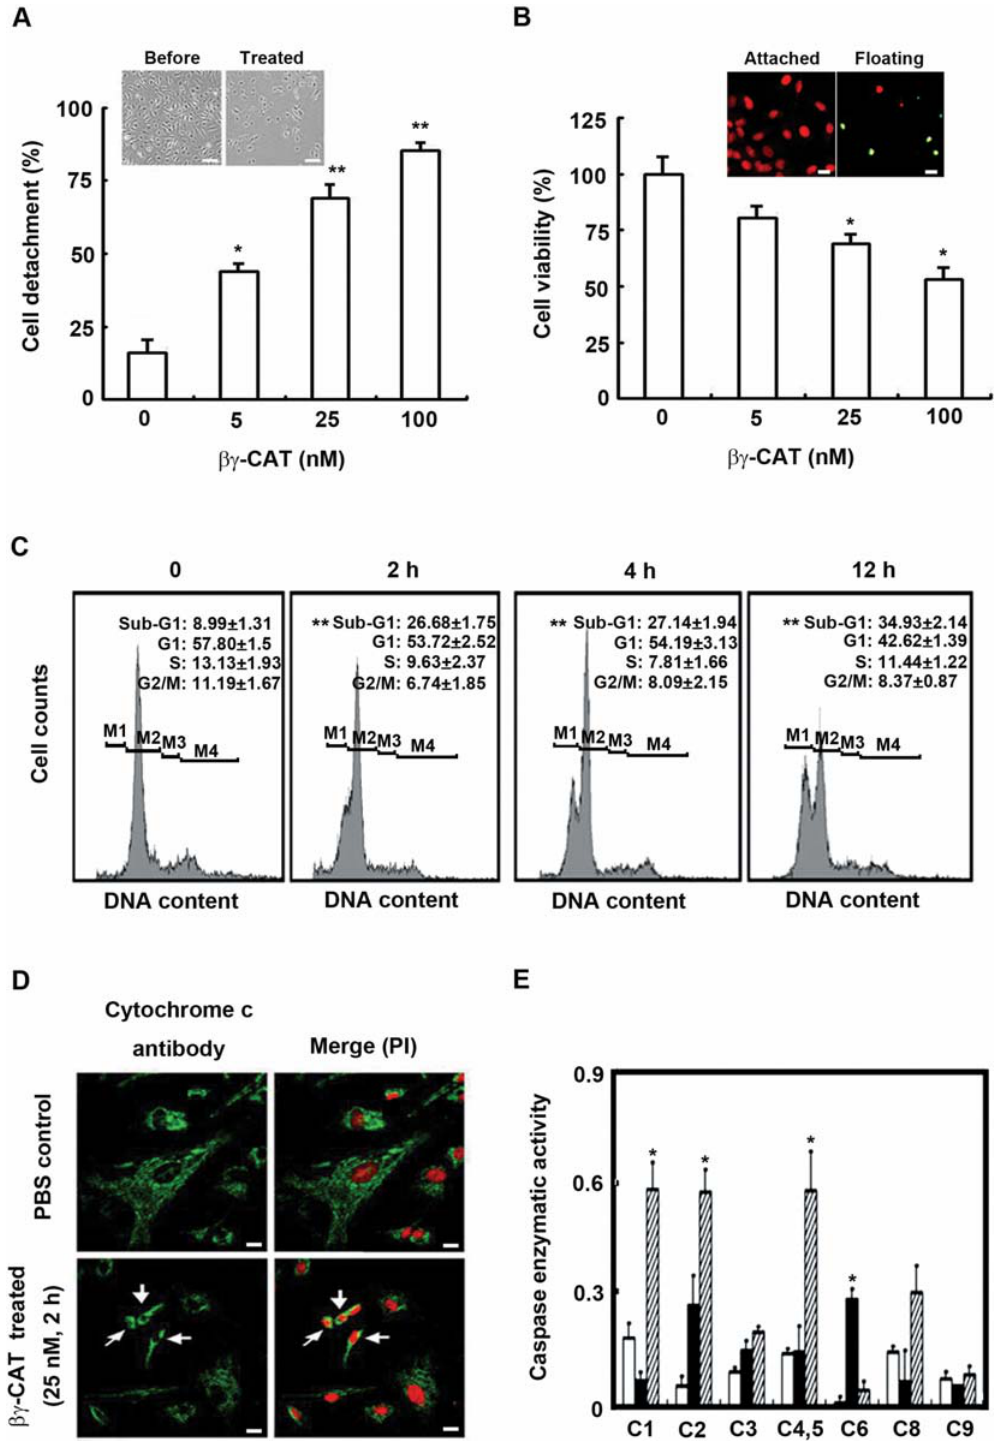
Figure 7. Induction of HUVEC detachment and apoptosis by high concentrations of bc -CAT. (A) HUVEC detachment induced by various concentrations of bc -CAT (treated for 2 h). Insert shows morphological changes of bc -CAT treated HUVECs. Scale bars equal to 100 m m. (B) Cell viability of HUVECs after treated with bc -CAT for 2 h as determined by MTT assay. Insert, TUNEL-staining of cells treated with bc -CAT (25 nM, 2 h). Nucleus was counter-stained by PI (red channel). The merge (yellow) fluorescent signals indicate TUNEL positive staining. Scale bars equal to 20 m m. (C) The DNA content of HUVECs treated with bc -CAT (25 nM) was detected using Hoechst by flow cytometry. Cells in the Sub-G 1 (M1), G 1 (M2), S (M3), and G 2 /M (M4) phases are indicated. (D) The release of cytochrome c was detected by indirect immunofluorescence. Nucleus was counter-stained by PI (red channel). Normal (top panels) and bc -CAT treated cells (bottom panels) were labeled with a specific antibody against cytochrome c (green channel). Cells with cytochrome c releasing are marked by arrows. Scale bars equal to 20 m m. (E) Activated caspase activities of HUVECs after treated with bc -CAT. White columns present PBS treated cells; black columns present the whole bc -CAT treated cells; diagonal columns present the floating cells after bc -CAT treated. In the parts of (D) and (E), HUVECs were treated by bc -CAT (25 nM) for 2 h. Data were expressed as means 6 SEM of triplicate measurements (*, p , 0.05; **, p , 0.01, in A, B and E, compared with zero bc -CAT; in C, compared with zero time point). doi:10.1371/journal.pone.0001770.g007 PLoS ONE |